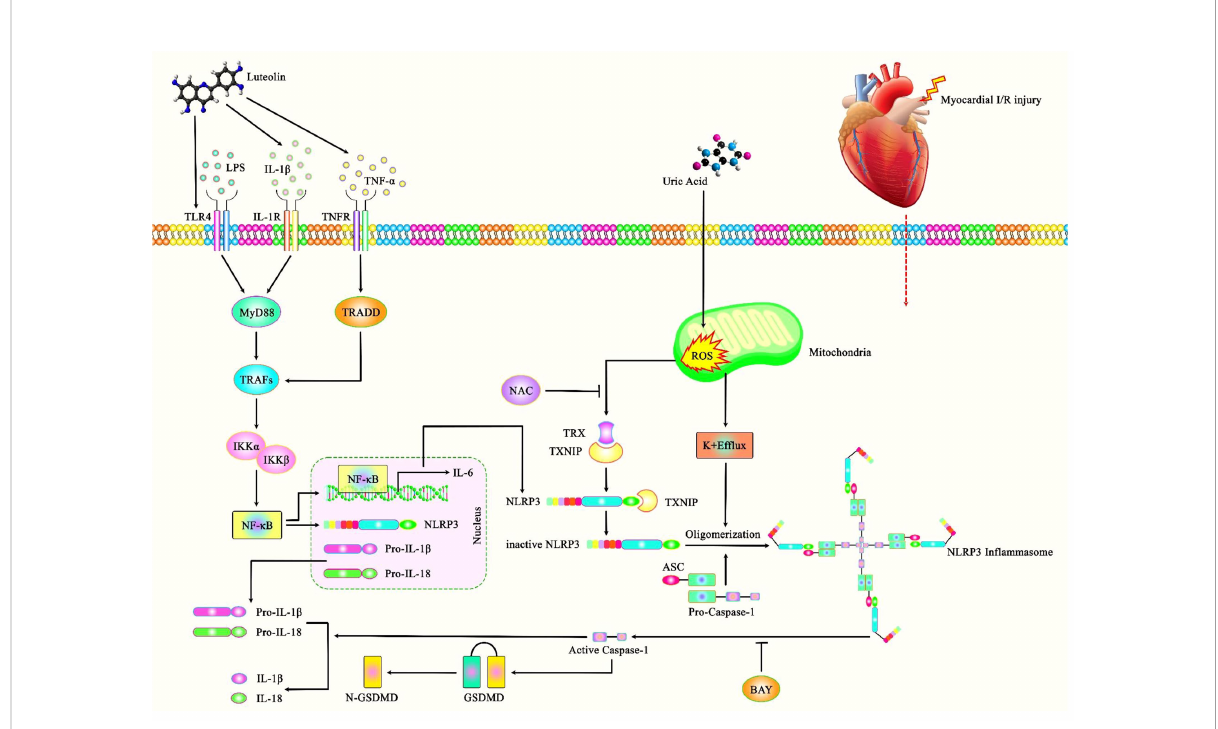
FIGURE 3 A schematic illustration of the role of NLRP3 In fl ammasome and its central role in the myocardial I/R injury. Accumulating evidence has illustrated that Luteolin could have a key role in protecting against myocardial I/R injury as opposed to Uric acid that could aggravate this injury through ROS/NLRP3 pyroptosis pathway. It has been reported that Luteolin could protect against myocardial I/R injury through TLR4/NF-kB/ NLRP3 in fl ammasome cascade by downregulating the expressions of NLRP3, ASC, caspase-1, TLR4, MyD88 and the phosphorylations of IKK a , IKK b , I k B a , and NF- k B (71).